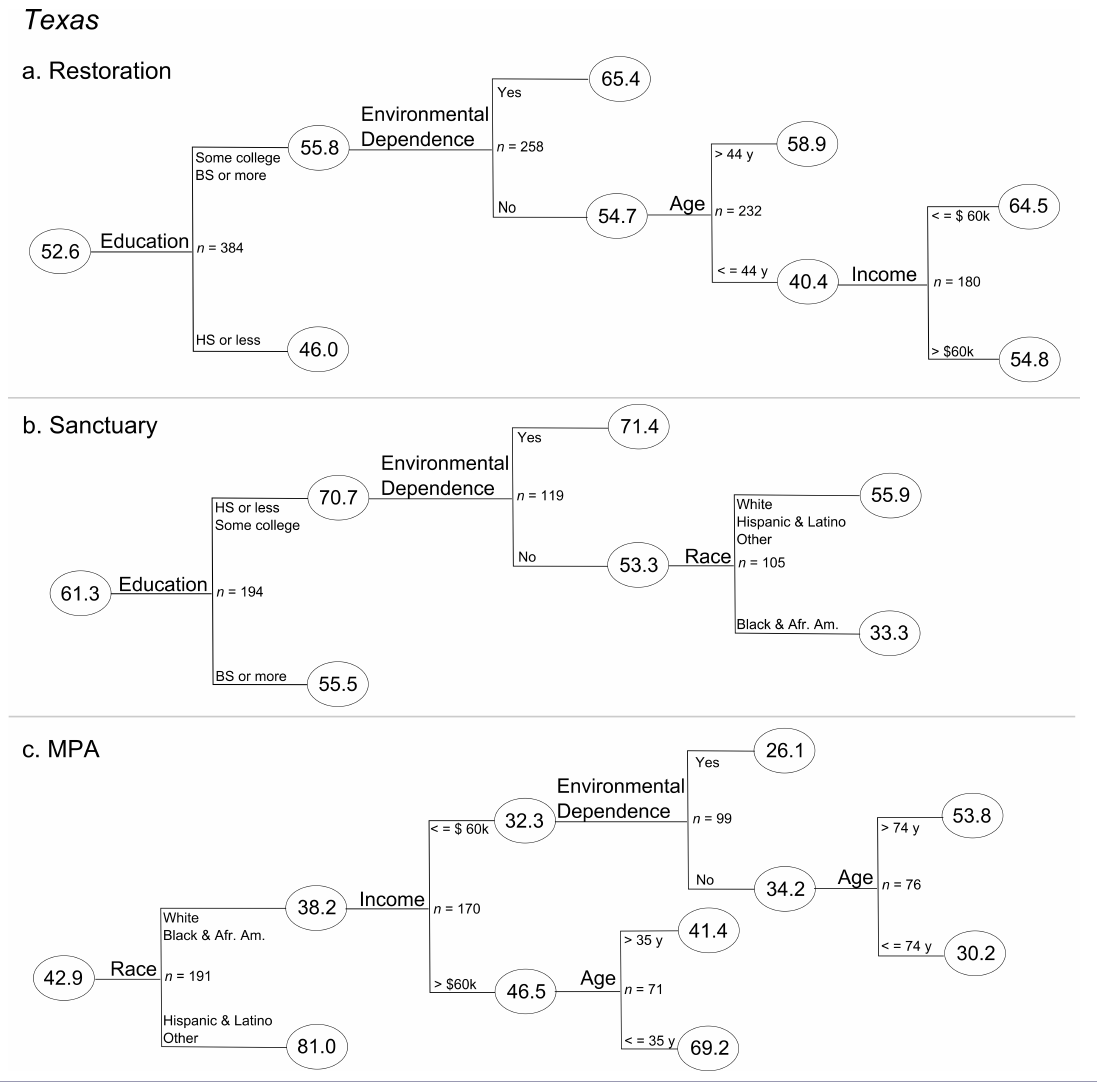
Fig. 7 . Tree showing the most powerful predictors for explaining variability among individuals who strongly support restoration (a), spawning sanctuaries (b), and MPAs as stewardship initiatives in Texas. The value shown within each oval is percent response for strongly support, and separate branches within the tree indicate statistical differences at P ≤